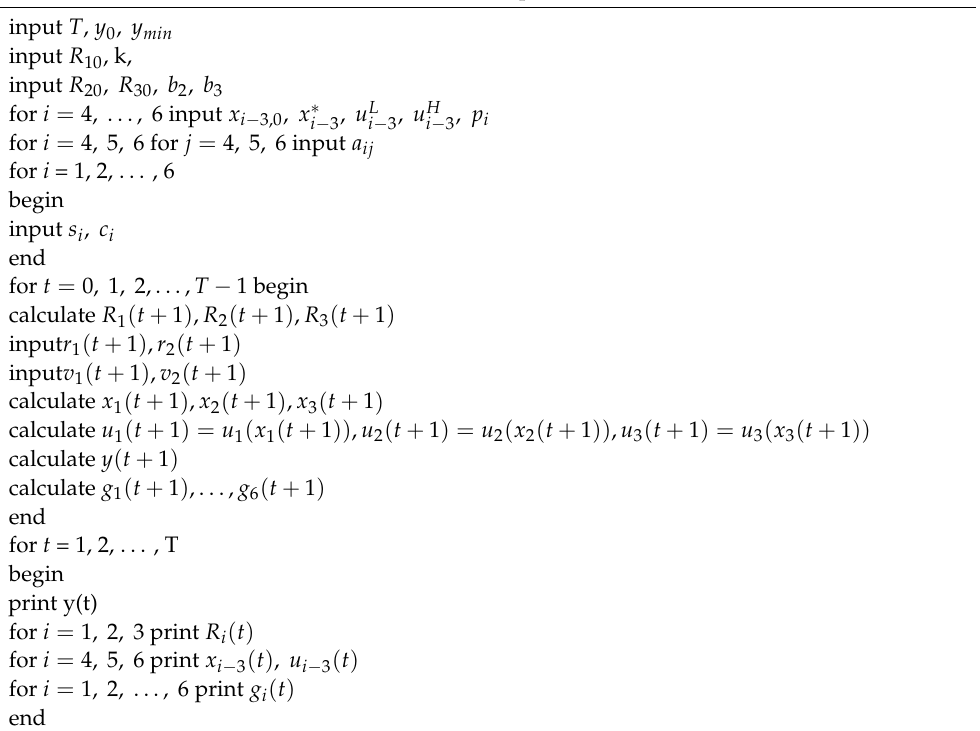
Algorithm 1. Numerical solution of the considered